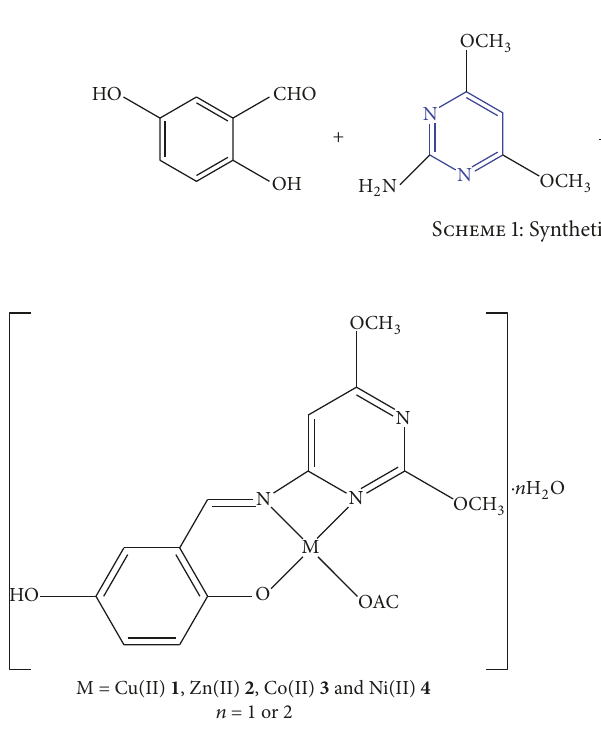
M = Cu(II) 1 , Zn(II) 2 , Co(II) 3 and Ni(II) 4 n = 1 or 2 Scheme 2: Proposed structure of complexes 1 – 4